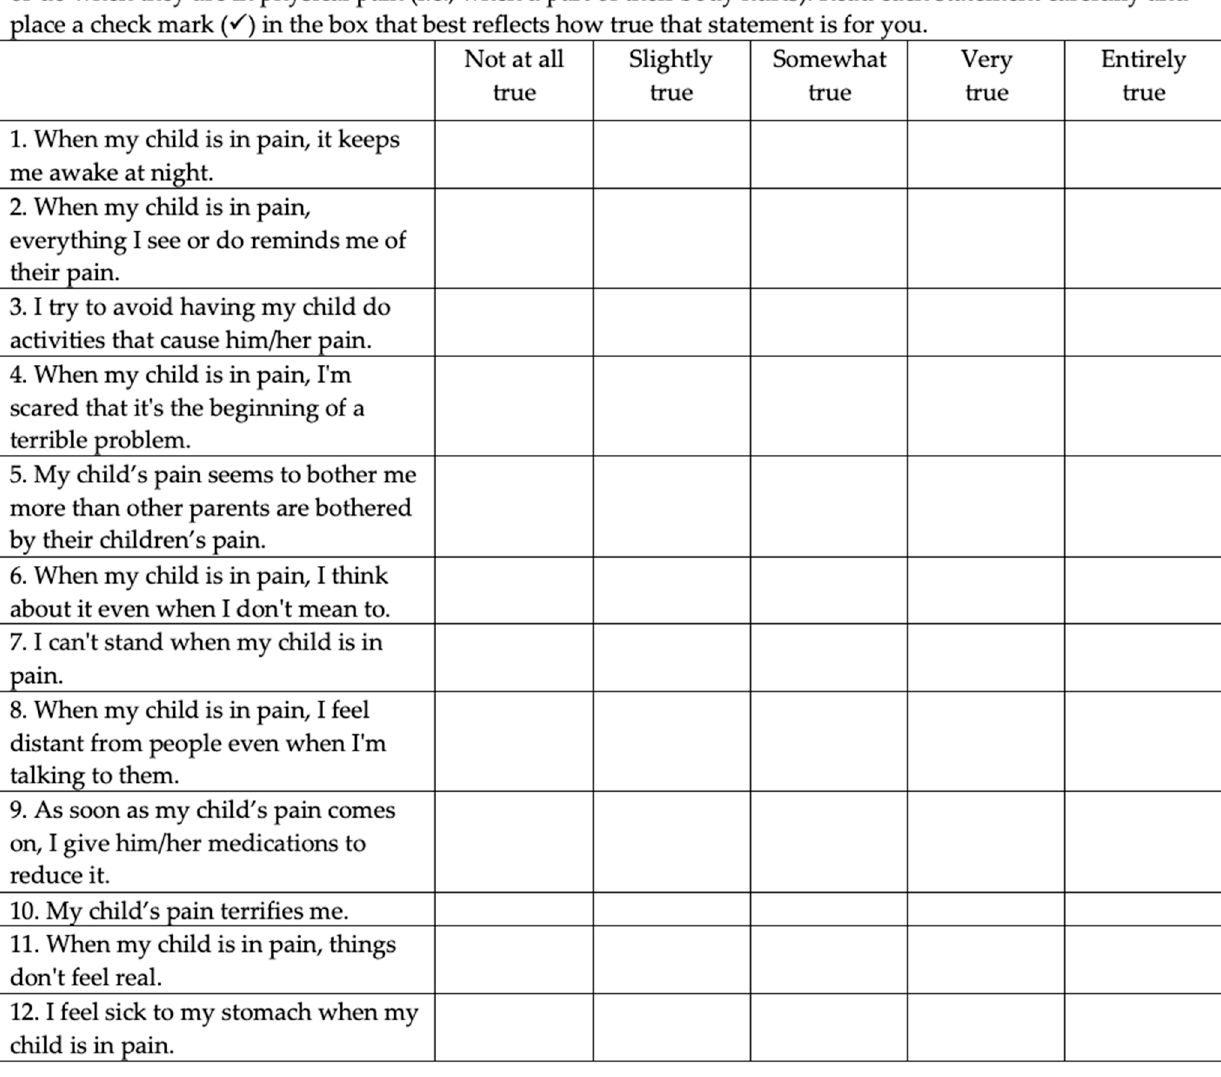
Figure 1. Final version of the Sensitivity to Pain Traumatization Scale-Parent Version (SPTS-P). Each of the 12 items are rated on a 5-point (0–4) scale where 0 = not at all true; 1 = slightly true; 2 = somewhat true; 3 = very true; 4 = entirely true.